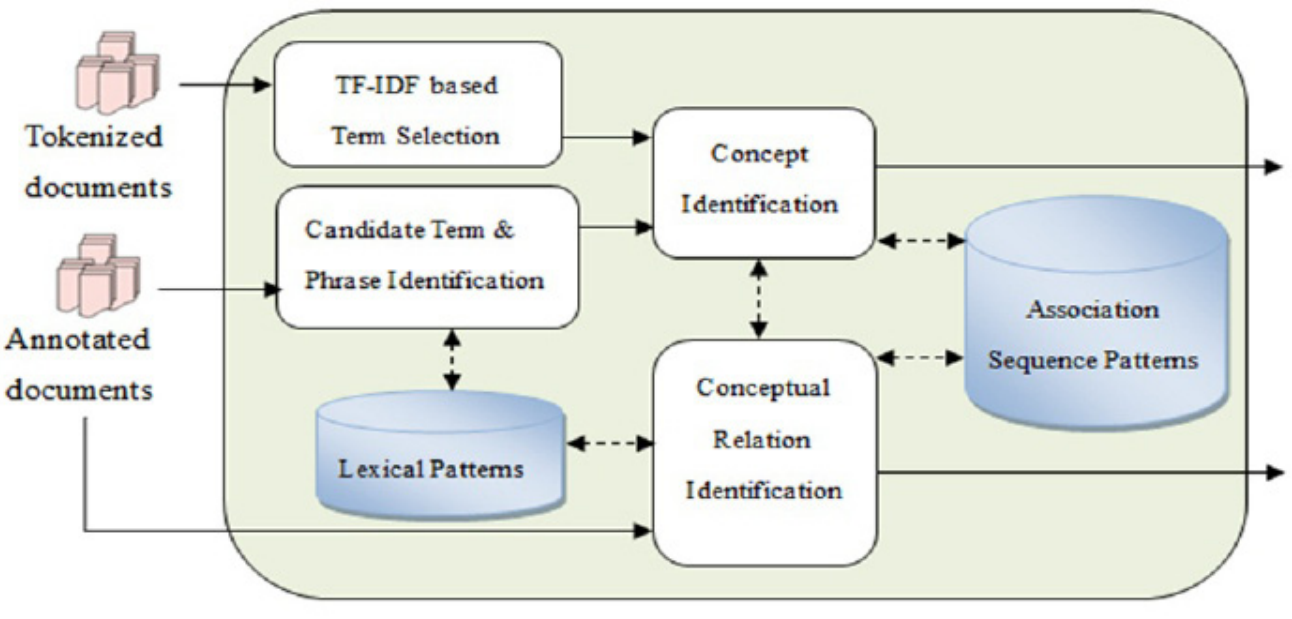
Figure 2. Learning